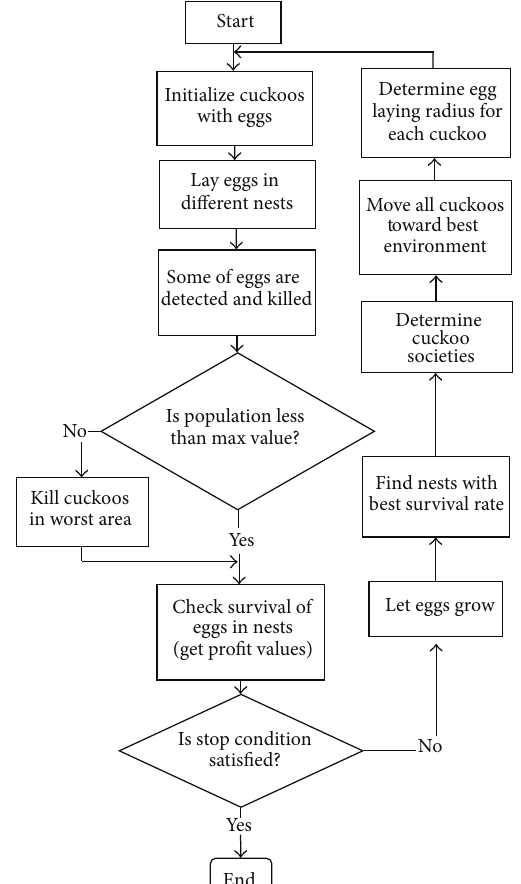
Figure 5: Flowchart of